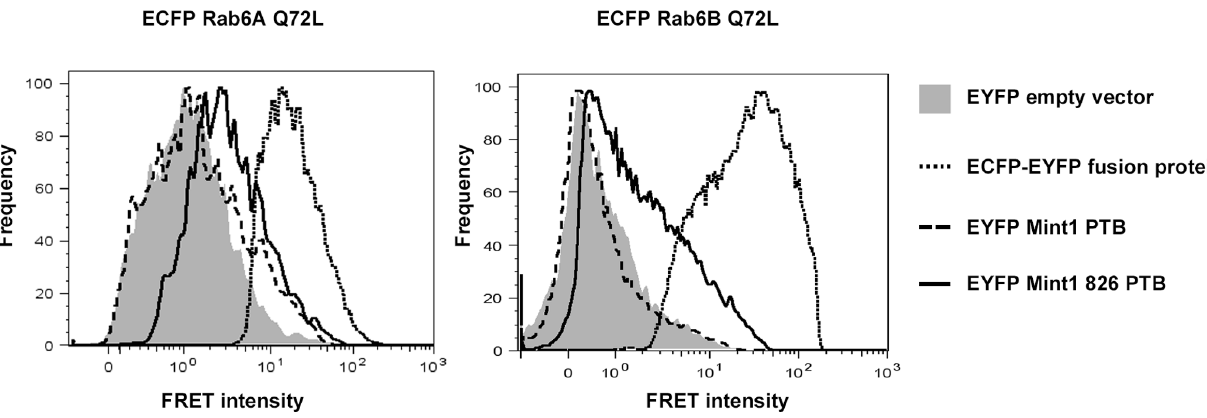
Figure 3. Flow cytometry based FRET analyses. HeLa T-REx cells were co-transfected with the indicated plasmids. Cells transfected with ECFP Rab6 and EYFP-C1 empty vector served as negative, EYFP–ECFP fusion protein as positive control. The graph displays EYFP fluorescence (550 nm) from 405 nm excitation of ECFP- and EYFP-double positive cells after correction of spectral bleeding of ECFP into the FRET (550 nm) channel and direct excitation of EYFP by the 405 nm laser